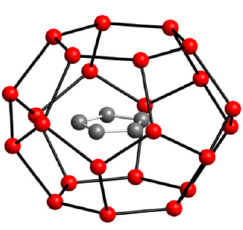
Figure 2. Cyclopentane hydrate. H 2 O molecules in red cage the guest hydrocarbon molecule inside.